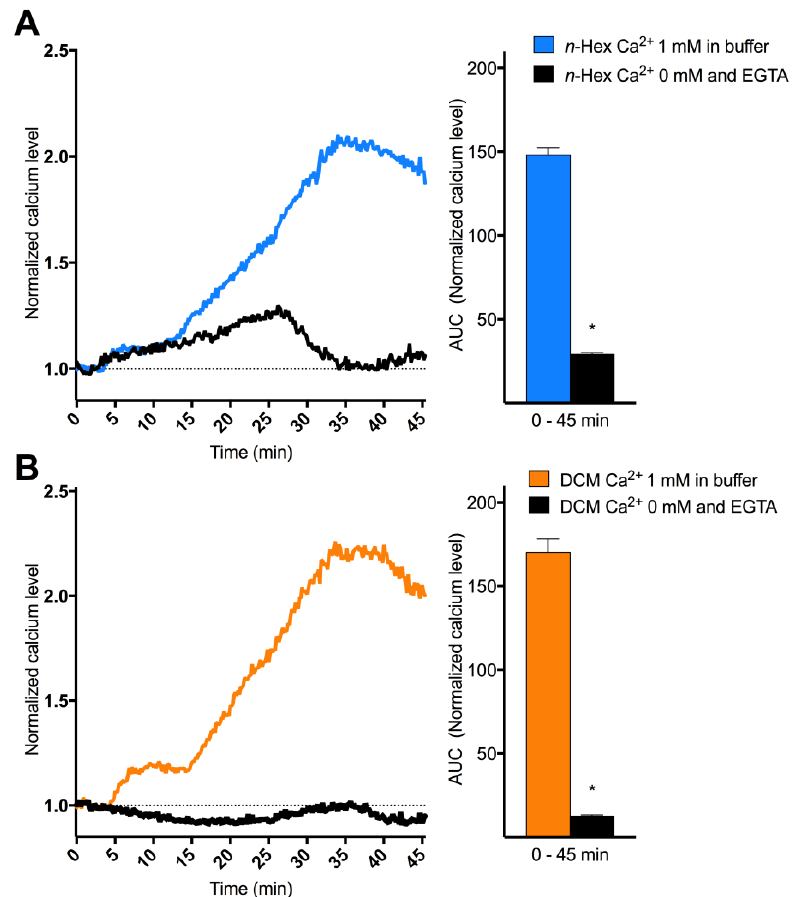
Figure 3. Origin and nature of n -Hex- and DCM-EOM-induced [Ca 2+ ] i responses. Cells were incubated in a buffer with or without Ca 2+ and ethylene glycol-bis(β-aminoethyl ether)- N , N , N ′, N ′-tetraacetic acid (EGTA), 30 min before exposure. Three min after measurements were started, the cells were exposed to n -Hex- ( A ) or DCM-EOM ( B ) at concentrations corresponding to 5 μg/mL of the original DEPs or vehicle control (DMSO). [Ca 2+ ] i level measured by normalized ratio of the Fura2-AM probe during exposure is presented as a graph and AUC from 1.0 at the Y -axis and 0–45 min, as mean and mean ± SEM ( n = 3), respectively. * Significantly different from calcium free exposure with EGTA ( p < 0.05).